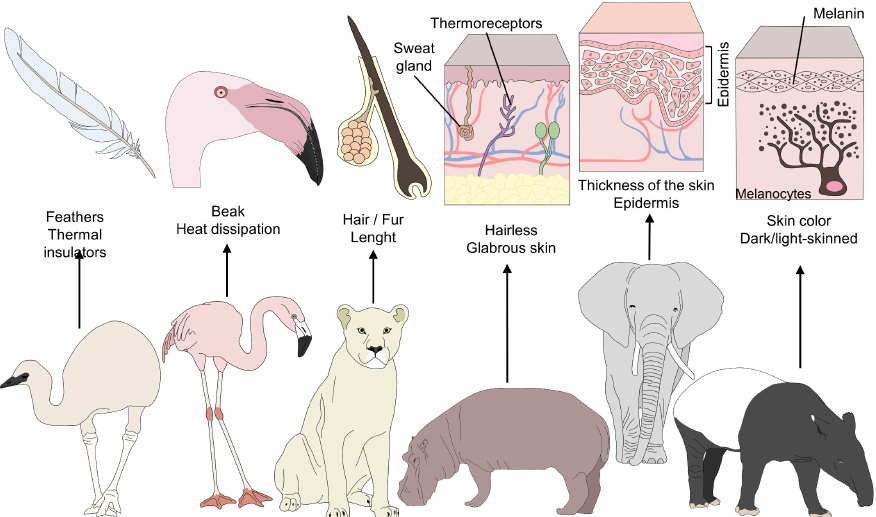
Figure 1. Morphological differences among furred, feathered, and bare-skinned animals. Thermoregulatory strategies in animals depend on various morphological elements. For example feathers serve as a thermal insulator in birds, and beaks facilitate heat dissipation. In contrast, the presence of hair and piloerection form a layer that conserves warm air to prevent any sudden drop in temperature. A thick layer of hair and dark hair color conserve heat and reduce radiation. Finally, skin color and the thickness of glabrous skin influence the amount of heat radiation in different